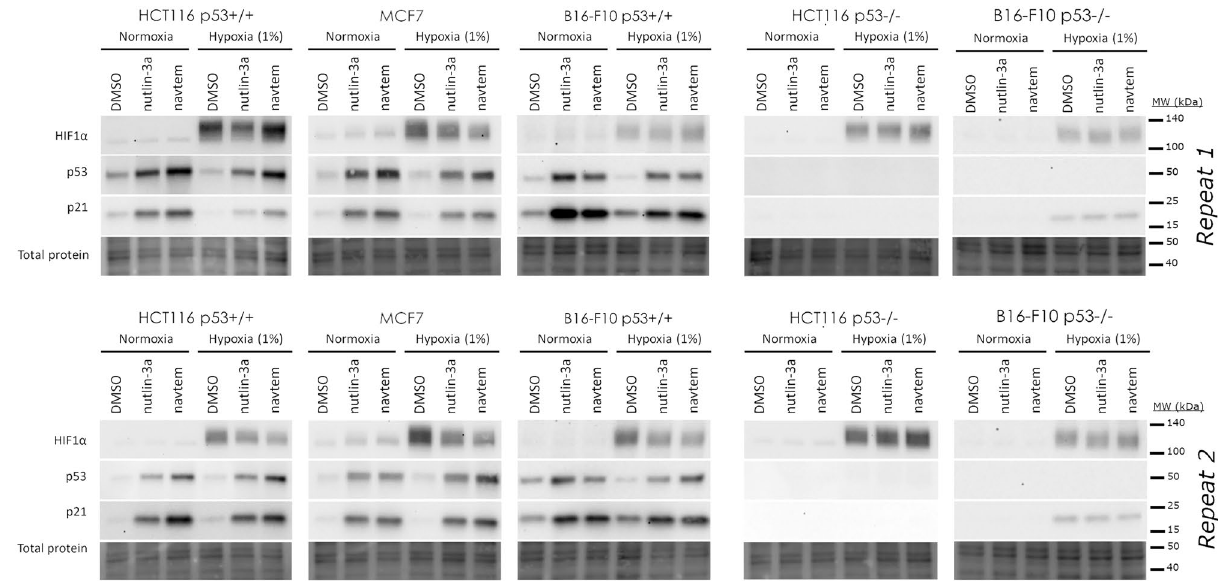
Figure 4. At the protein level, MDM2 inhibitors activate the p53-p21 pathway in hypoxic p53 WT cancer cells. The levels of HIF-1α, p53 and p21 levels were visualized after 24 h treatment with DMSO, nutlin-3a and navtemadlin (abbreviated navtem in figure) in either normoxia or hypoxia. Human cells (HCT116 and MCF7) were treated with 2 µM nutlin-3a or 0.5 µM navtemadlin, while mouse cells (B16-F10) were treated with 10 µM nutlin-3a or 2 µM navtemadlin. Whole membranes from two independent experiments were sequentially blotted using antibodies against each protein. Images of immunoblots and total protein levels (loading control) are cropped from whole blots; full-length blots are shown in SI Figs.